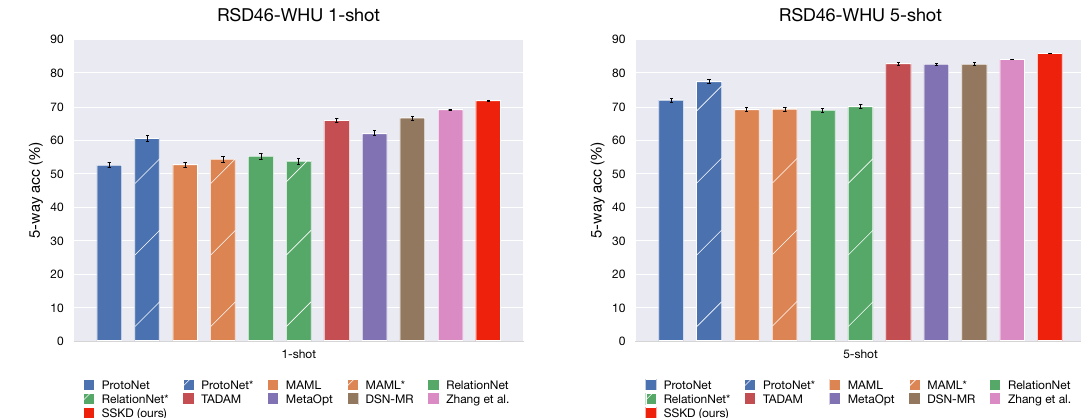
Figure 12. The few-shot classification performance (with 95% confidence intervals) on the RSD46-WHU dataset, the striped bars indicate the re-implementation of approaches with a Resnet-12